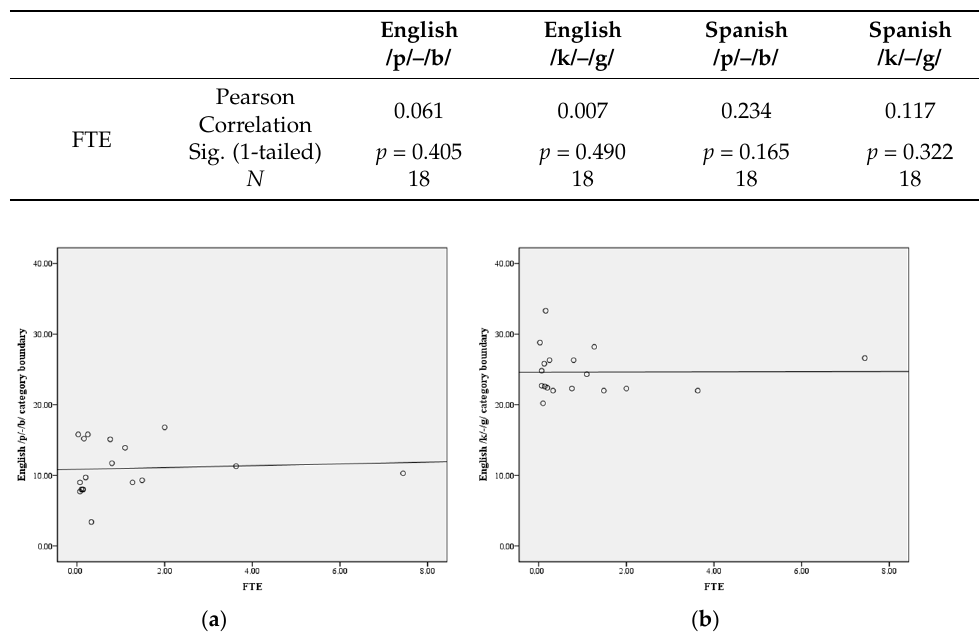
Figure 3. Scatterplots with fit lines for FTE ( x axis) and category boundary ( y axis) in English by the Spanish learners of English. ( a ) Category boundary for the /p/–/b/ contrast in English. ( b ) Category boundary for the /k/–/g/ contrast in English.